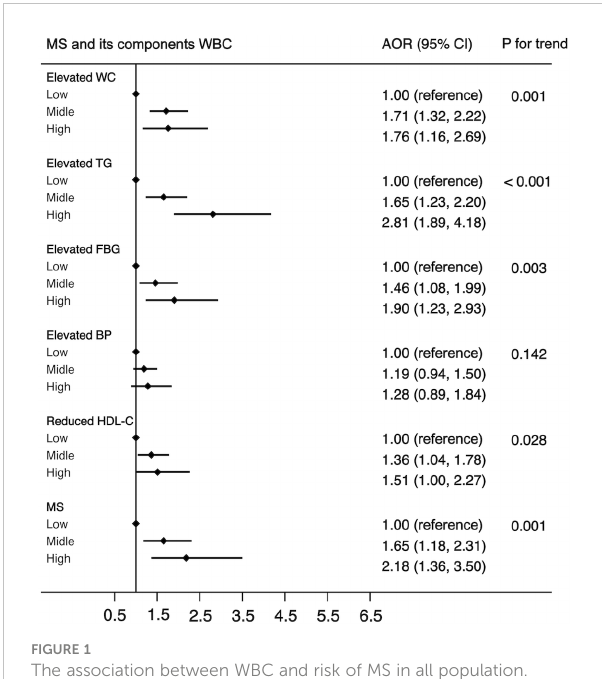
FIGURE 1 The association between WBC and risk of MS in all population. Adjusted for sex, age (<=39, 40-64, >=65), BMI (<25, >=25 & <30, >=30), residence (city, suburb, town or rural village), smoking (smoker or non-smoker) and drinking status (drinker or non- drinker), HOMA-IR (yes or no). Data are shown as OR and 95%